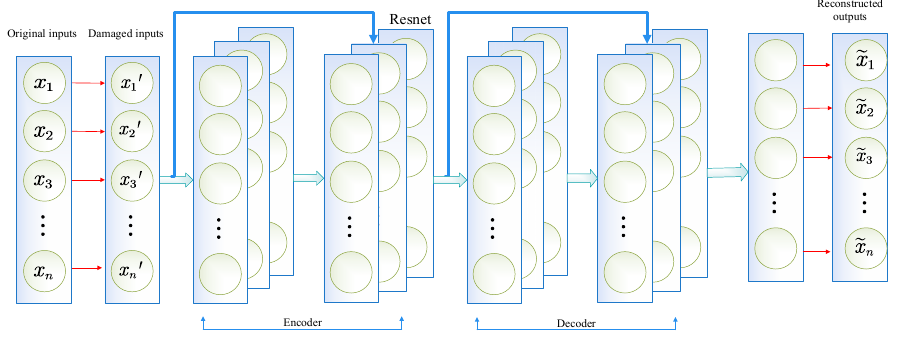
Figure 3. The overview of our proposed RDAE network.